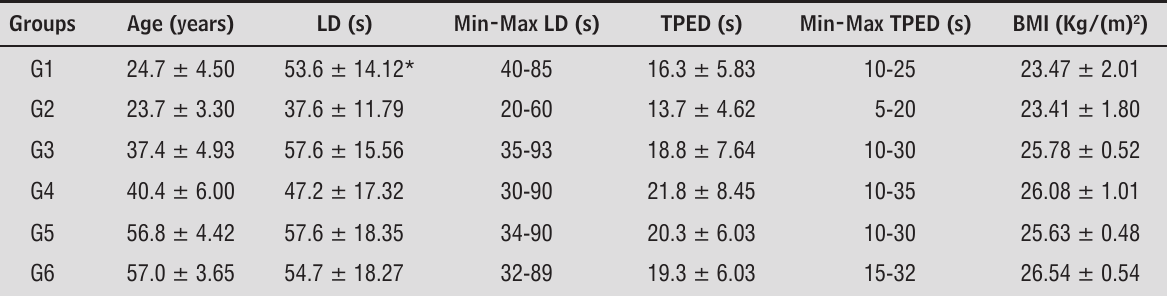
Table 1 - Characterization of the subjects studied